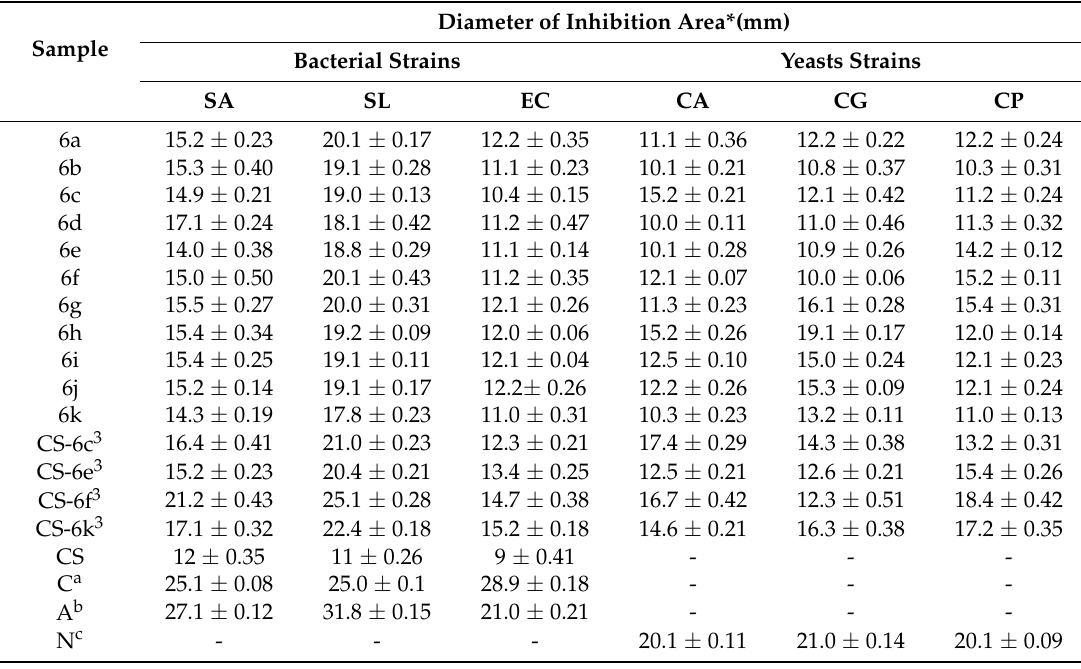
Table 3. Antibacterial/antifungal inhibition area (mm) of XTDs (6a–k) and CS-XTDs.